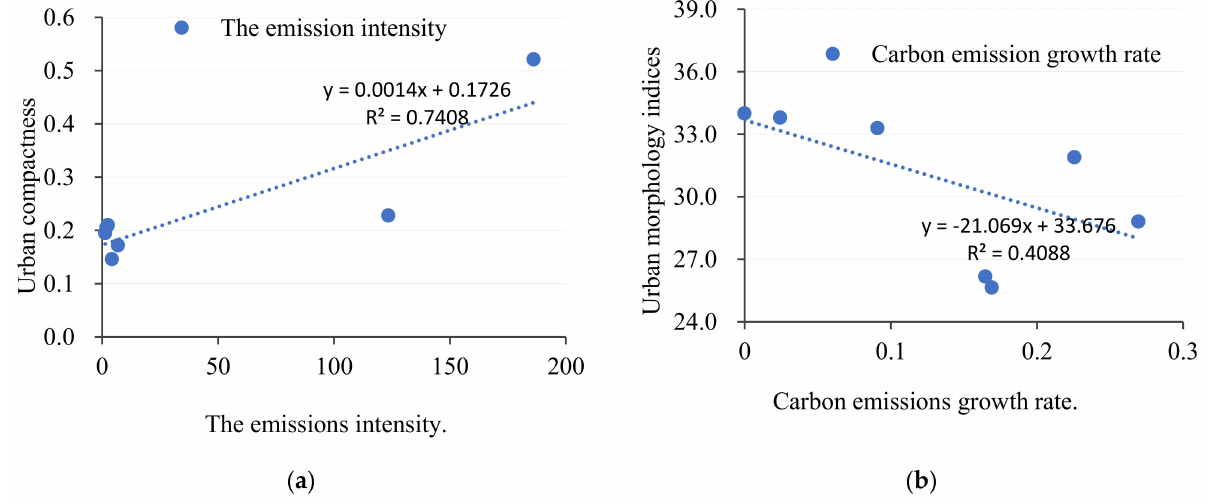
Figure 11. Correlation analysis. ( a ) Correlation analysis of the emissions intensity and urban compact- ness. ( b ) Correlation analysis of the carbon emissions growth rate and the urban morphology